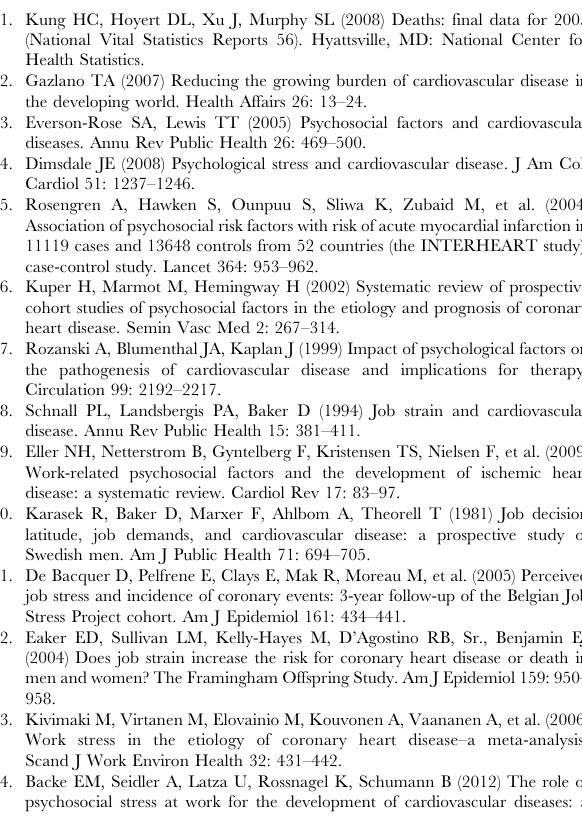
Table S2 Comparison of baseline characteristics for participants included in sub-analysis (N= 17,415) and participants excluded from sub-analysis due to missing data (N= 4671). Table S3 Items used to create job strain categories. Table S4 Hazard rate (HR) and 95% confidence interval of cardiovascular disease by job strain, sample restrict- ed to women with completed data on extensive set of potential mediators and confounders (N= 17415). Table S5 Cardiovascular risk factors and other charac- teristics according to job strain and job insecurity for subset of women with complete data on traditional behavioral and non-behavioral CVD risk factors (N=